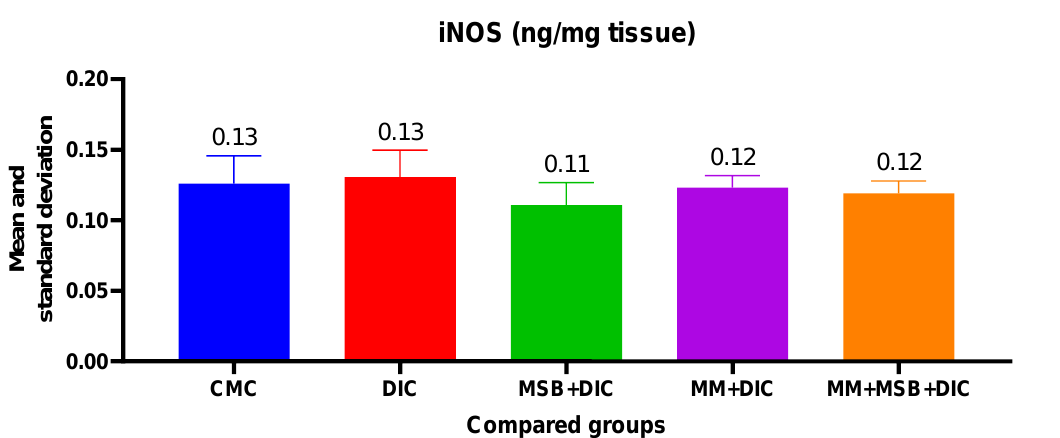
Figure 2. The mean value and standard deviation of iNOS between the analyzed groups. Group I- CMC, negative control group; group II-DIC, disease control group; group III-MSB+DIC, group receiving MegaSporeBiotic; group IV-MM+DIC, group receiving MegaMucosa; group V-MM+MSB+DIC, group receiving MegaSporeBiotic and MegaMucosa.